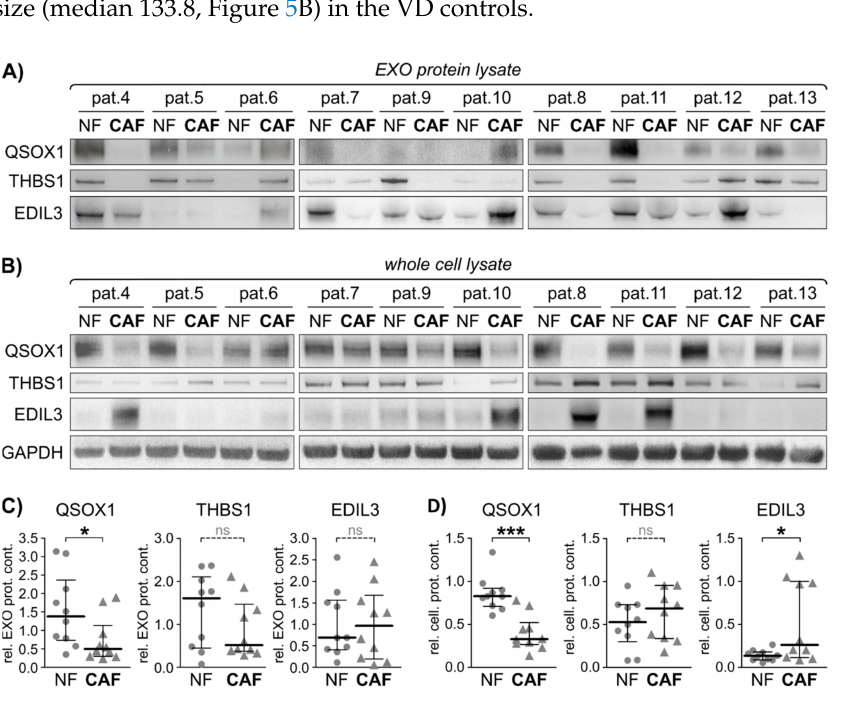
Figure 4. Exosomal fibroblast activity marker validation in an independent validation cohort. Twenty additional fibroblast cell lines derived from 10 CRC patients were subjected to cellular protein and EXO isolation. Exosomal protein was isolated and subjected to immunoblot. ( A ) Immunoblot analysis of quiescin sulfhydryl oxidase 1 (QSOX1), thrombospondin 1 (THBS1), EGF-like repeats and discoidin domains 3 (EDIL3), in primary fibroblasts-derived EXOs. ( B ) Immunoblot analysis of QSOX1, THBS1 and EDIL3 in primary fibroblasts whole cell lysate, including GAPDH as loading control. ( C ) Graphical analysis of EXO protein immunoblots shown in ( A ) using ImageJ, relative to GAPDH. Mann-Whitney-U test: * p < 0.05. ( D ) Graphical analysis of cellular protein immunoblots shown in ( B ) using ImageJ, relative to GAPDH. Mann-Whitney-U test: * p < 0.05, *** p < 0.001. ns = not